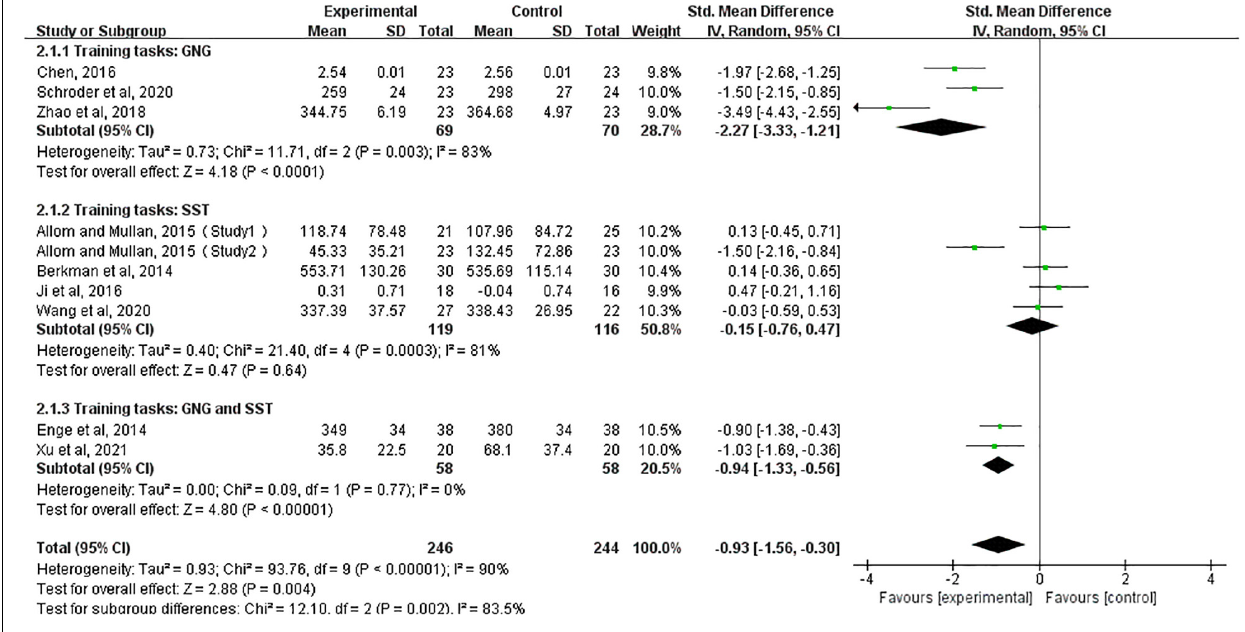
FIGURE 3 | Immediate effects after training, based on subgroup forest plots for different training tasks (GNG, Go/no-go tasks; SST, stop-signal tasks; GNG and SST, Go/no-go tasks and stop-signal tasks).